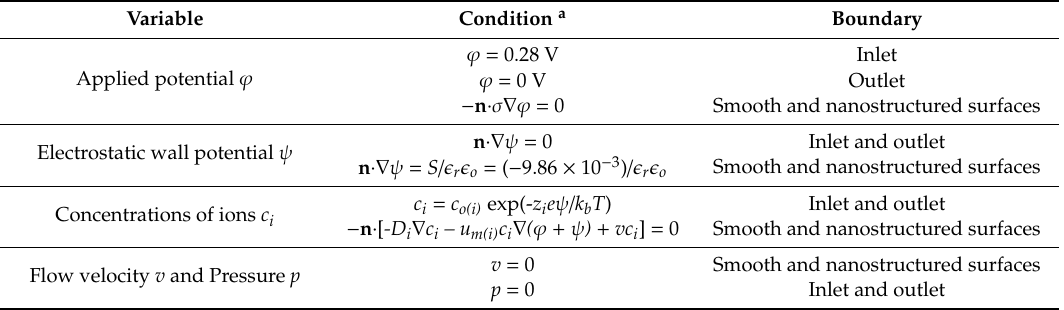
Table 1. Boundary conditions for 2-D simulation of a steady-state electroosmotic flow (EOF). Variable Condition